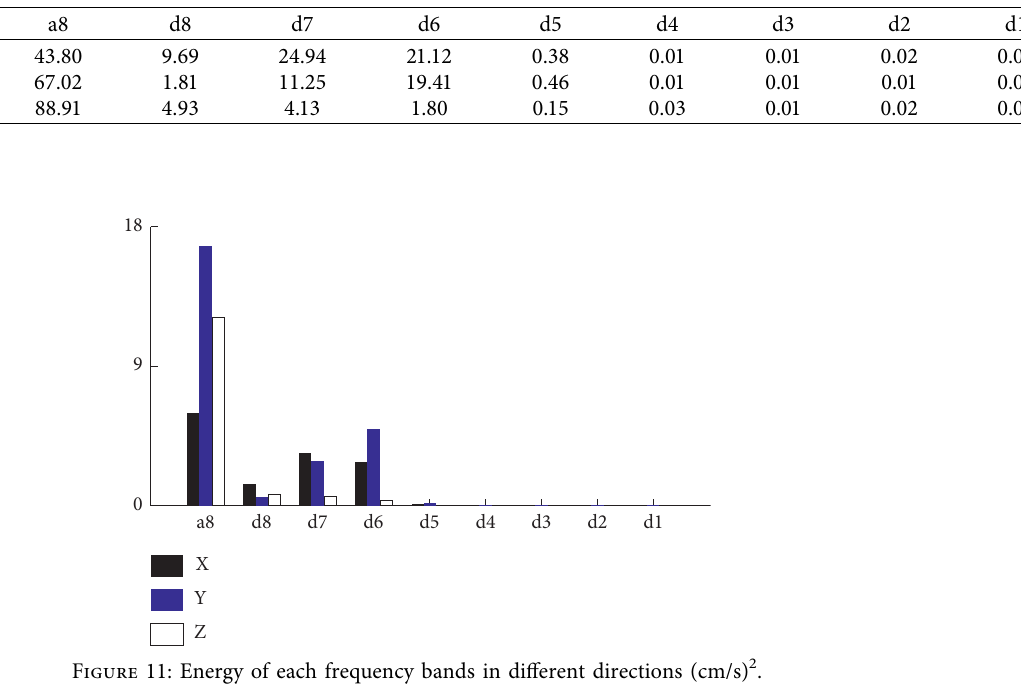
Table 5: Energy percentage of each frequency band in different directions (%).